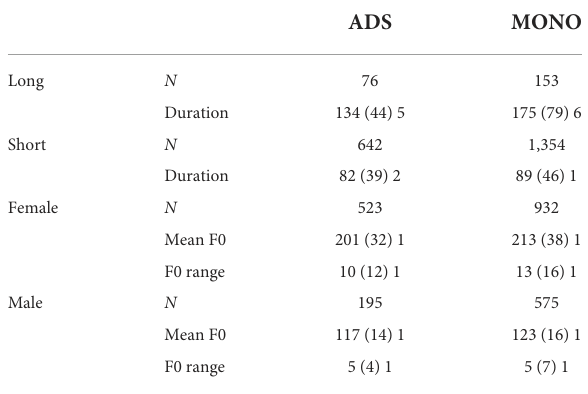
TABLE 7 Duration (ms), mean F0 and F0 range (Hz) for vowels in Nungon ADS and MONO: mean (standard deviation) standard